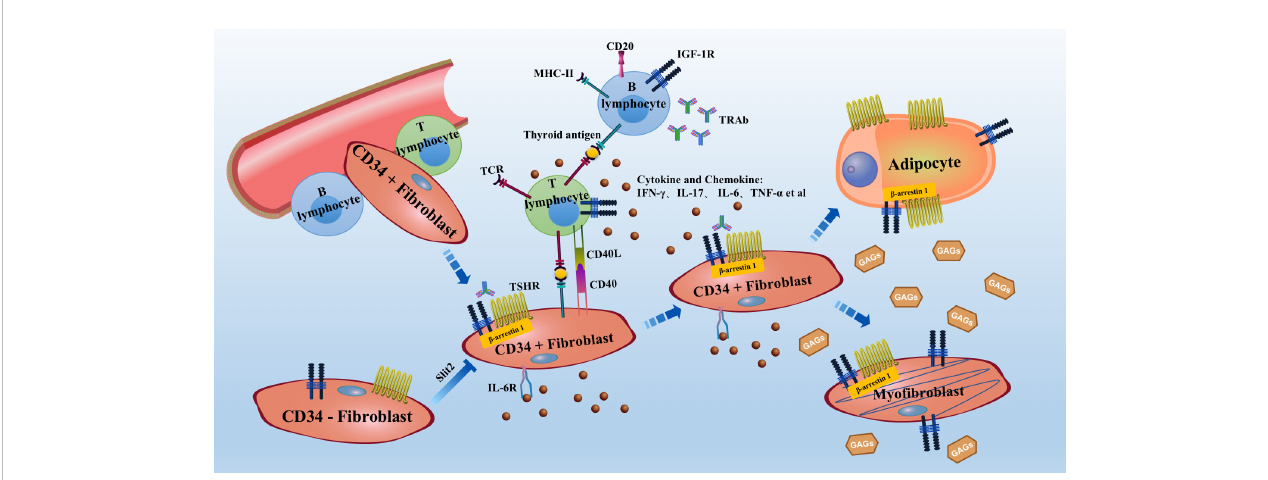
FIGURE 1 Schematic of the theoretical pathogenesis of GO Bone marrow mononuclear cell-derived CD34+ fi broblasts enter the orbit from the circulation and express low levels of TSHR, thyroglobulin and other thyroid antigens. APCs, such as B lymphocytes or macrophages, present antigens to antigen-speci fi c T lymphocytes and activate them. Activated T lymphocytes release cytokines and chemokines, further causing B lymphocytes to produce antibodies. These processes form an in fl ammatory microenvironment in the orbit. OFs can also act as APCs. In the in fl ammatory microenvironment, activated T lymphocytes activate OFs. Activated OFs further secrete cytokines and chemokines and produce excessive levels of GAGs, leading to swelling of the orbital tissue. CD34+ fi broblasts are found in orbit with CD34 − fi broblasts. CD34+ fi broblasts further differentiate into myo fi broblasts or adipocytes, resulting in thickening of the extraocular muscles and exophthalmos. TSHR expression is increased during adipogenesis. IGF-1R, TSHR, IL-6R, CD20 and TNF- a are current therapeutic targets for GO. APC, antigen-presenting cell; GAG, glycosaminoglycan; GO, Graves ’ orbitopathy; OFs, orbital fi broblasts; TSHR, thyrotropin receptor; IGF-1R, insulin-like growth factor-1